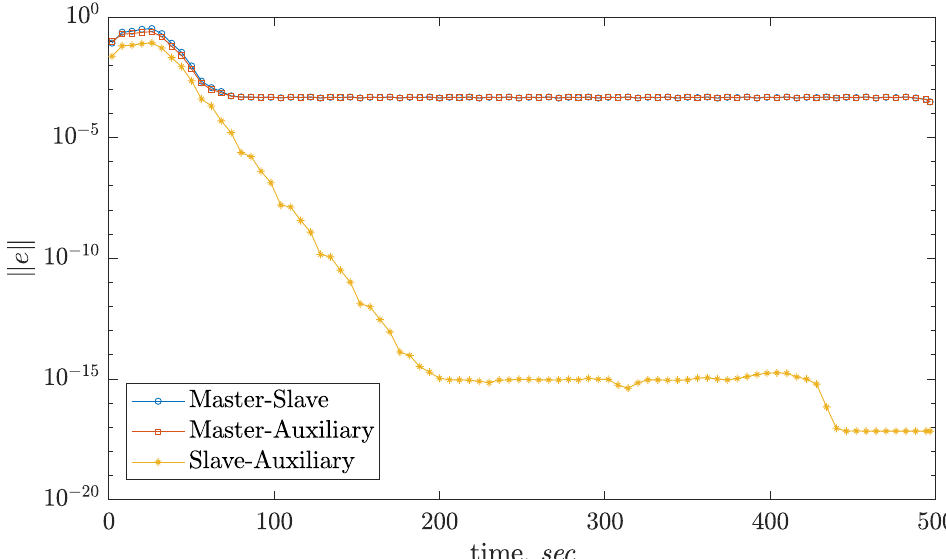
Figure 4. Synchronization error between computer models, smoothed with a median filter; the window size is 600 samples.